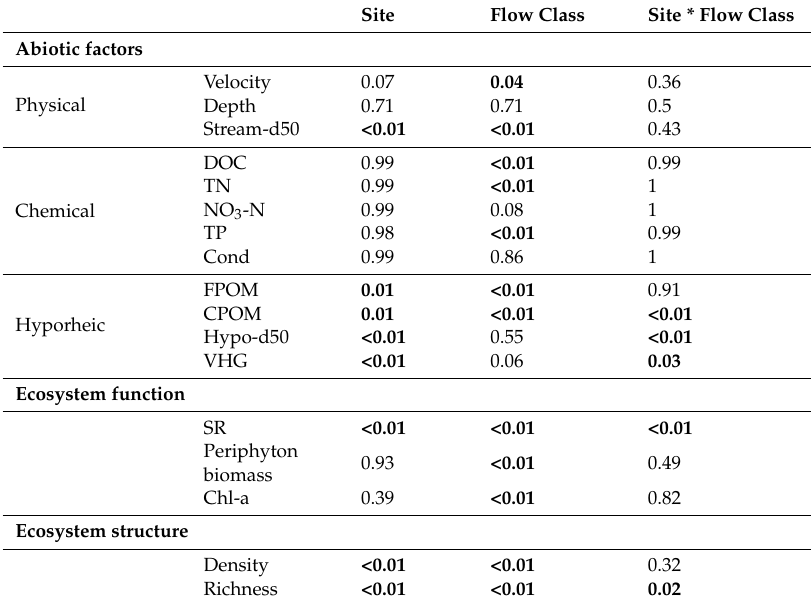
Table 3. Two way ANOVA results of the effects of site and flow class on all measured variables. Bold numbers indicate statistical significance ( α = 0.05).